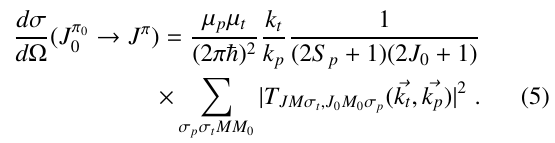
Figure 2. Illustration of the surrogate reaction method. Here, d interacts with D to form the required compound nucleus B ∗ . d may be scattered inelastically or may gain or lose nucleons to Schematic showing the translation of quantum num- form b . Figure 3. bers used in the two-neutron basis into those required for calcu- lations in the di-neutron pseudo-particle basis.